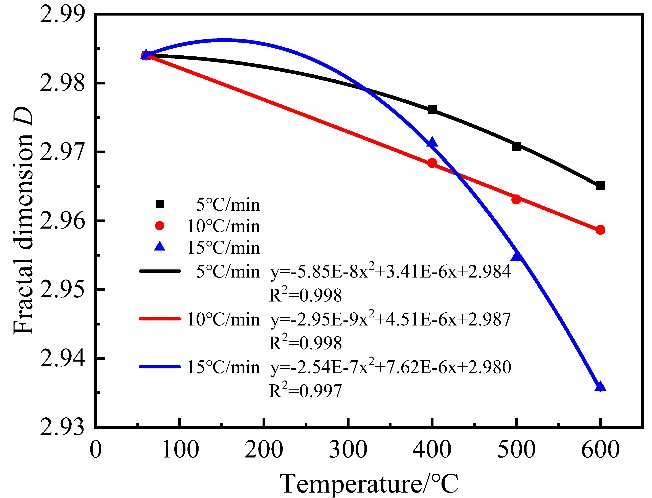
Figure 15. Relationship between fractal dimension and temperature.